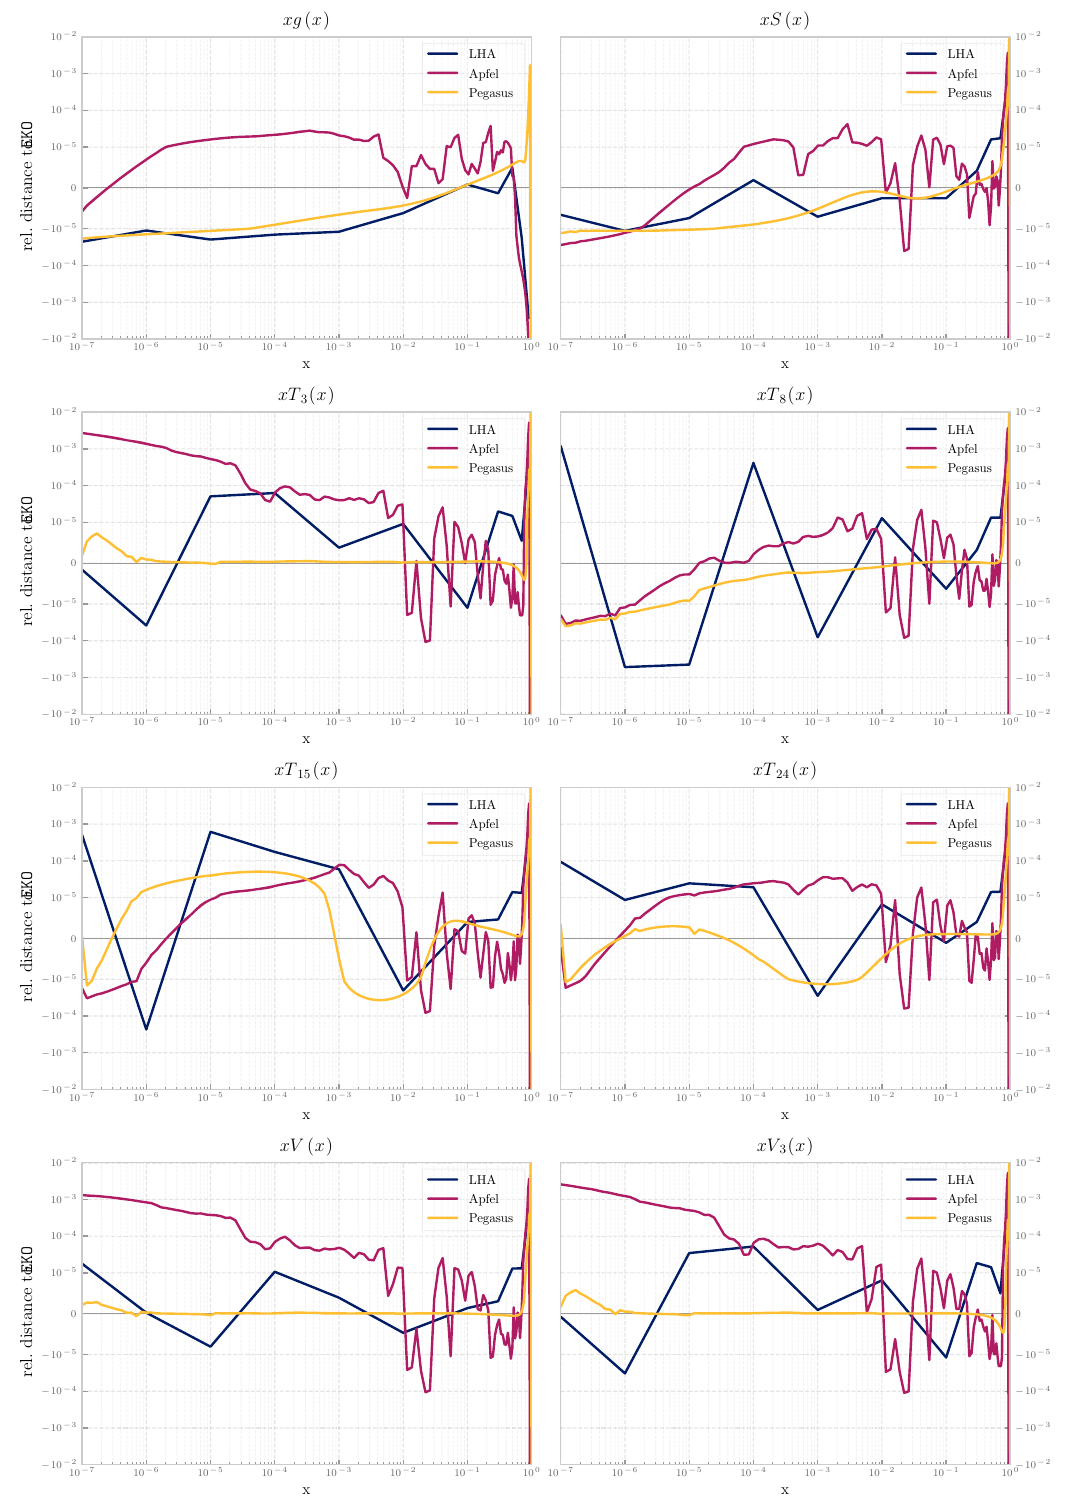
Fig. 1 Relative differences between the outcome of NNLO QCD evolution as implemented in EKO and the corresponding results from [46], APFEL [24] and PEGASUS [27]. We adopt the settings of the Les Houches PDF evolution benchmarks